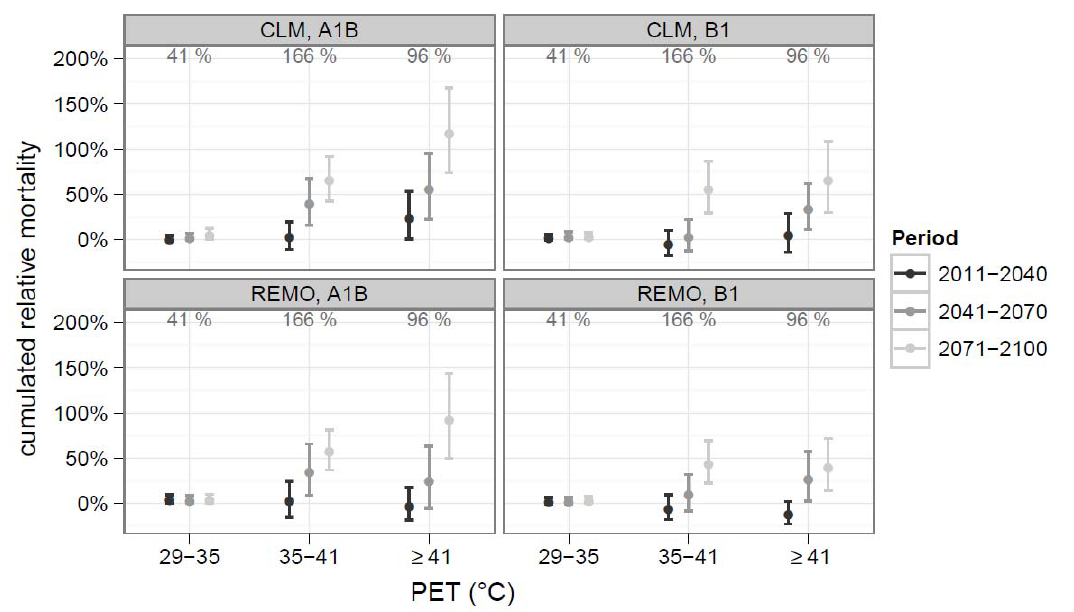
Figure 4. Changes in cumulated heat related mortality without long-term adaptation. The value of the period of examination is shown in gray in the upper margin of each